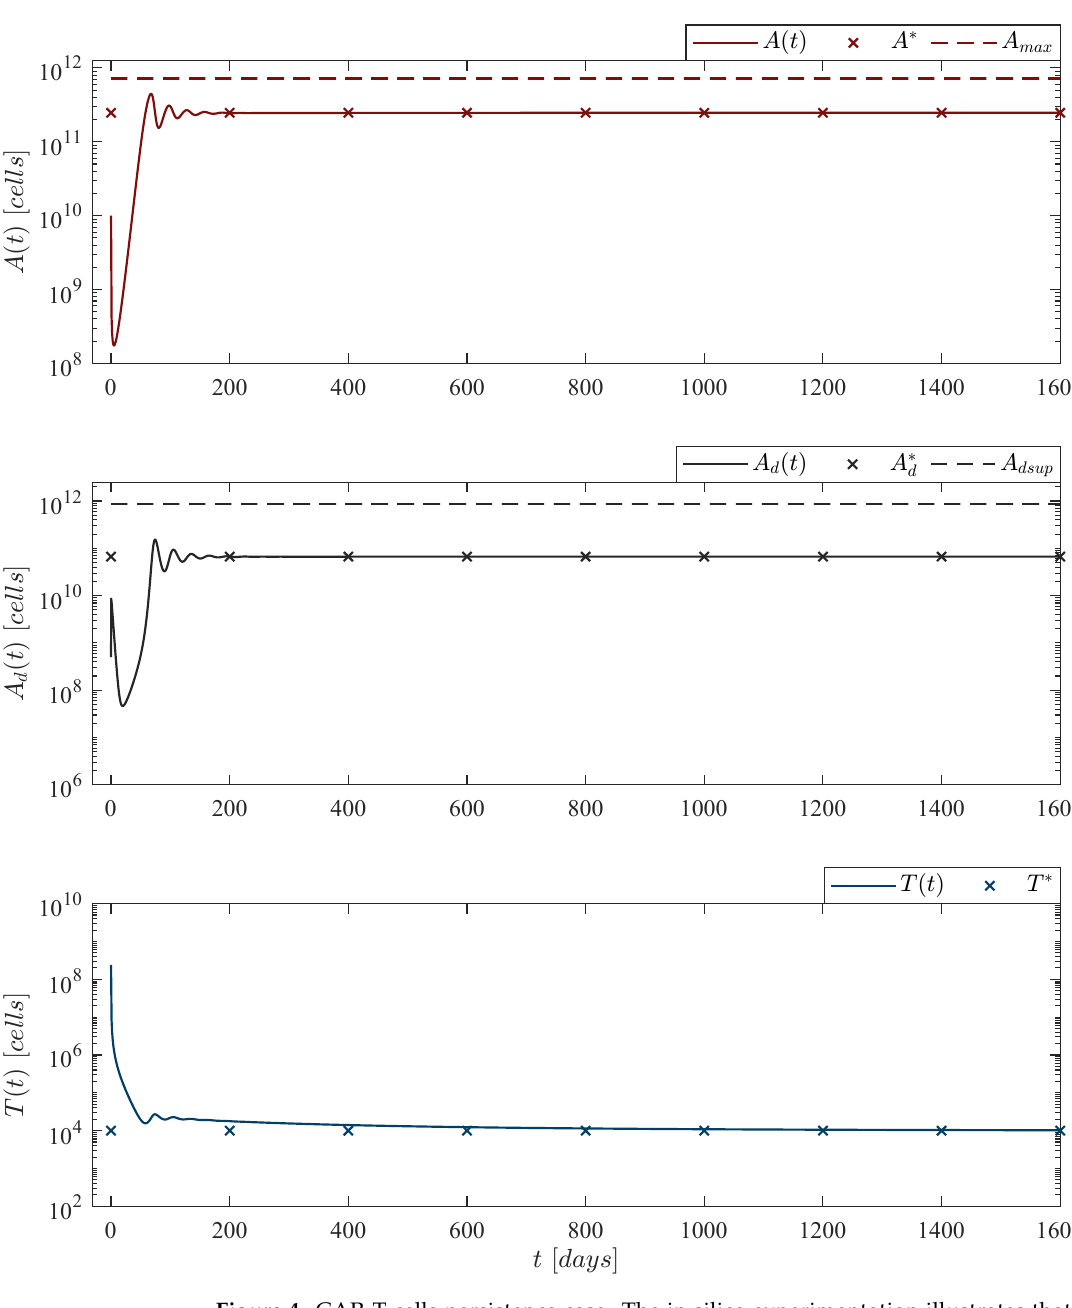
Figure 4. CAR-T cells persistence case. The in silico experimentation illustrates that by fulfilling condition (7) CAR-T cells can persist after a single application with an absolute count of 10,001 cells, just above the threshold of clinical detectability reported in [44]. Nonetheless, in our mathematical model persistence of CAR-T cells is linked to the survival of leukemia cells. Solutions of live leukemia cells [ A ( t )] , dead leukemia cells [ A d ( t )] and CAR-T cells [ T ( t )] go to the equilibrium point (cid:0) (cid:1) (cid:39) (cid:0) (cid:1) A ∗ , A ∗ , T ∗ 2.4716 × 10 11 ,6.6835 × 10 10 ,1.0001 × 10 4 . The analytical analysis shows that the d numerical value of ρ T is directly related to this result. For this case, parameter values are set as follows: ρ A = 0.1680, ρ T = 2.9409 × 10 − 13 , µ T = 1/14, and α T = 1.2560 × 10 − 7 by Equation